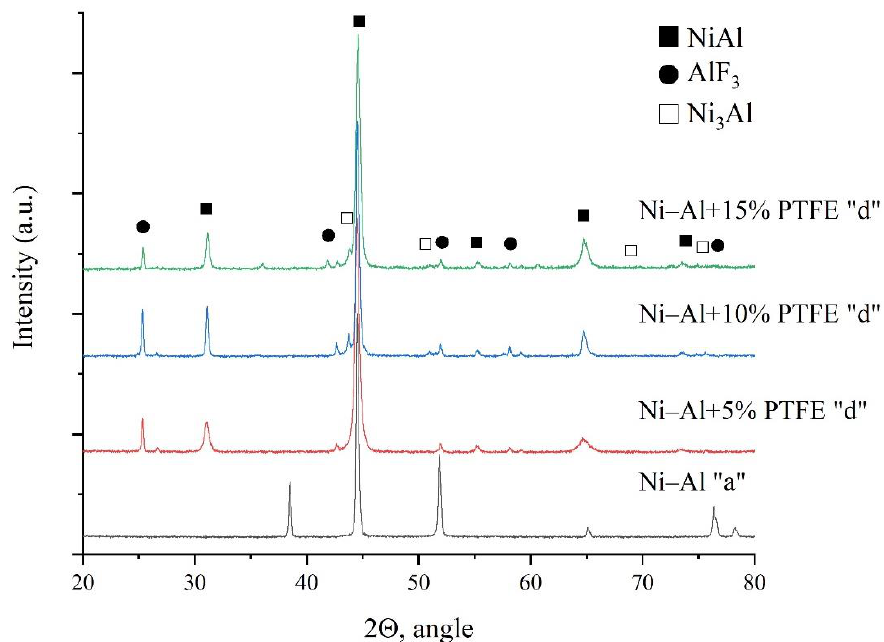
Figure 17. XRD of specimens after shock-wave loading at 1.5 km/s.